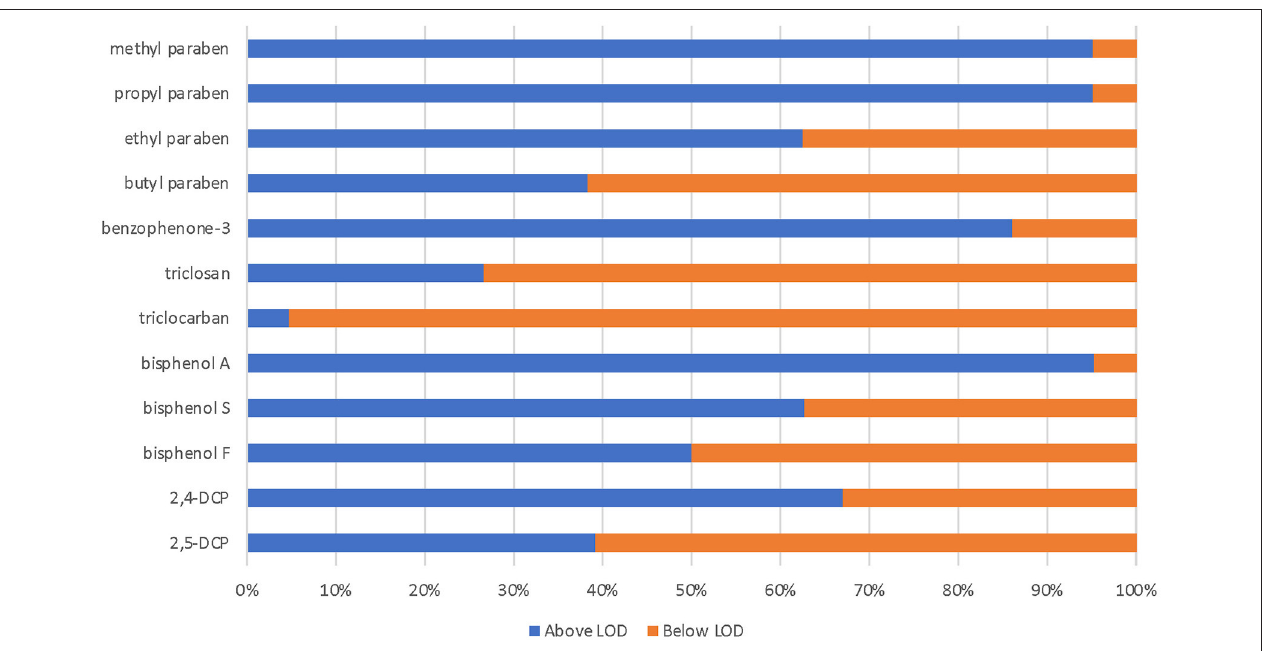
FIGURE 1 | Percent of urine samples with urine biomarker above the limit of detection (LOD).